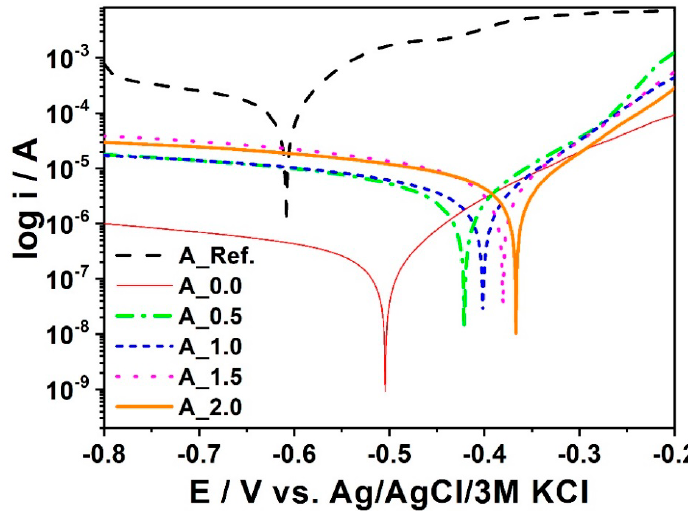
Figure 14. Polarization curves registered for samples subjected to the activation process. Materials 2018 , 11 , x FOR PEER REVIEW